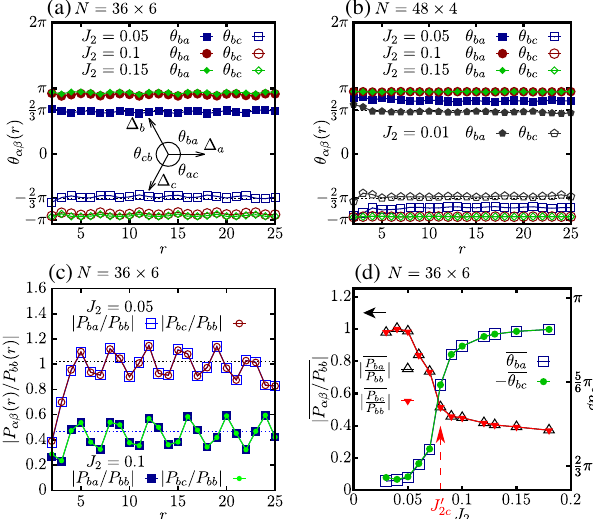
FIG. 5. Transition from the d þ id -wave SC2 phases to SC0 phase. (a) The spatial dependence of relative phases for SC order parameters for various J 2 on the L y ¼ 6 ( L x ¼ 36 ) system. r is chosen along the x direction r ¼ ð r; 0 Þ . (b) The relative phases for SC order parameters on the L y ¼ 4 ( L x ¼ 48 ) system. (c) The ratio of the magnitudes of different SC correlations. The dashed line indicates the average over distances. (d) The spatial average values of the relative phases of SC order parameters and the ratios of magnitudes of different SC correlations for various J 2 . All results are obtained at J χ ¼ 0 . 05 with bond dimension M ¼ 10 000 ( M ¼ 8000 ) on L 6 ( L 4 ) systems. The doping y ¼ y ¼ level is δ ¼ 1 = 12 .